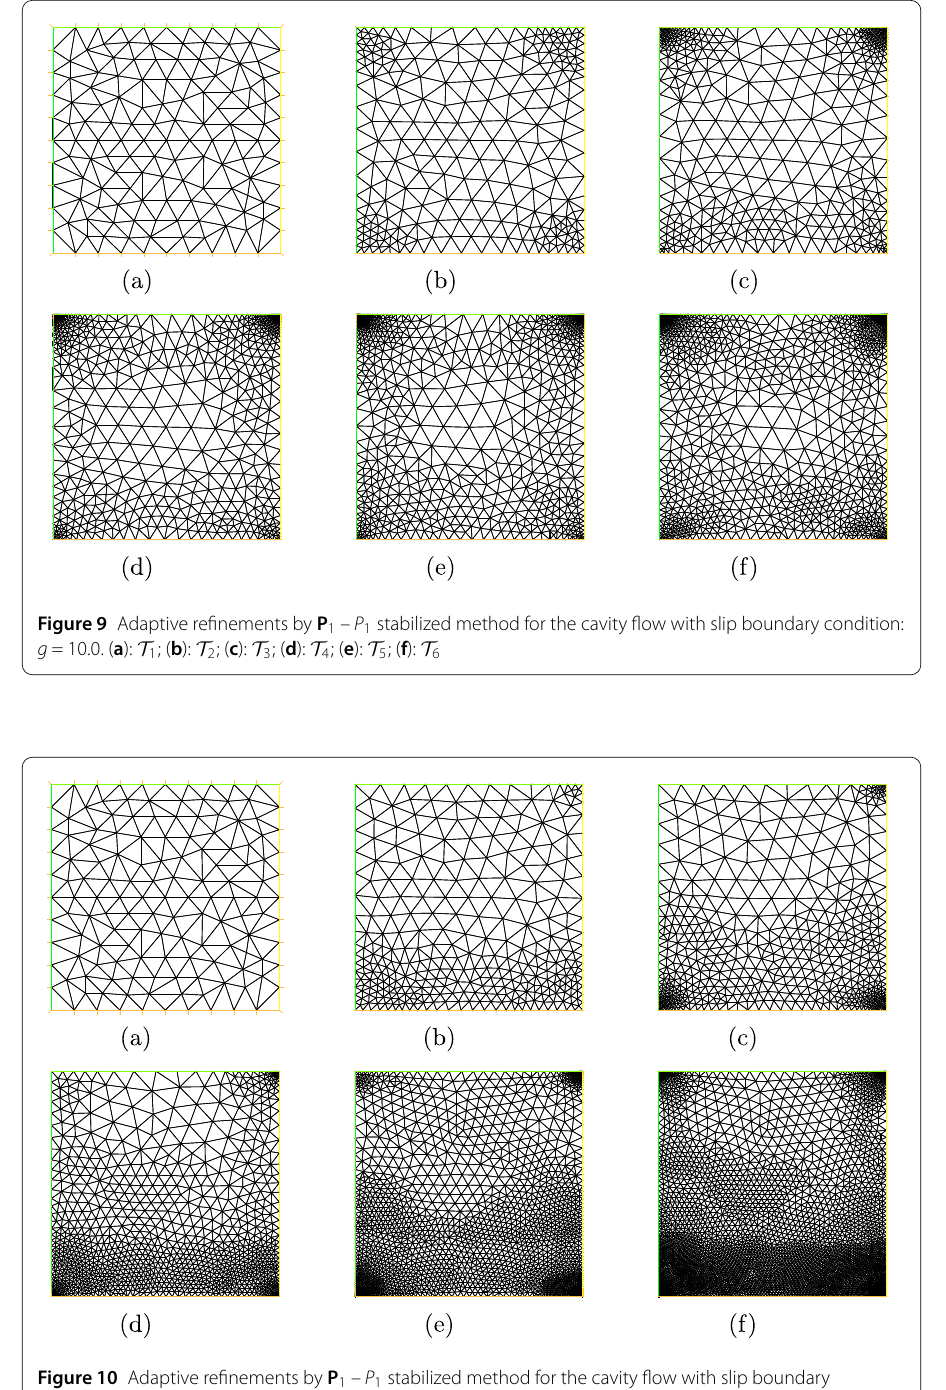
Figure 10 Adaptive refinements by P 1 – P 1 stabilized method for the cavity flow with slip boundary condition: g = 100.0. ( a ): T 1 ; ( b ): T 2 ; ( c ): T 3 ; ( d ): T 4 ; ( e ): T 5 ; ( f ): T